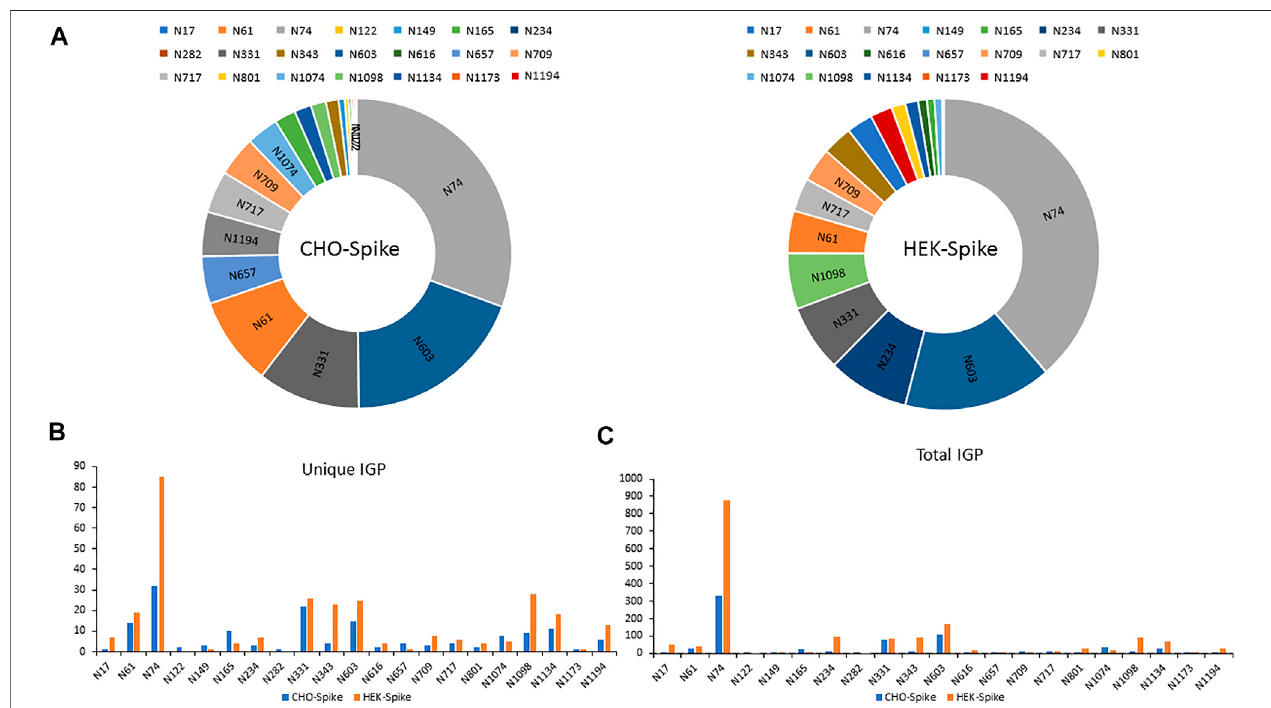
FIGURE4|(A) Theidenti fi edN-sitesandtheirrelativeabundanceofglycopeptidesfromCHO-SpikeandHEK-Spikeproteins.Thesite-speci fi csummaryofunique IGP (B) and total IGP (C) of glycopeptides identi fi ed from CHO-Spike and HEK-Spike proteins.